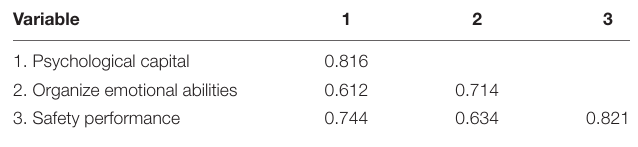
TABLE 5 | Test of discrimination